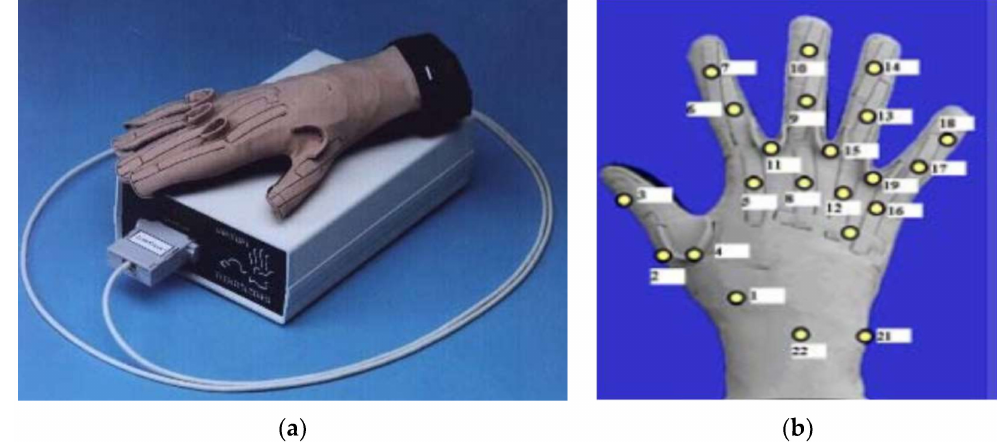
Figure 19. Glove systems. ( a ) Virtual Technologies’ CyberGlove and control box and ( b ) the location of 22 bend sensors on the glove